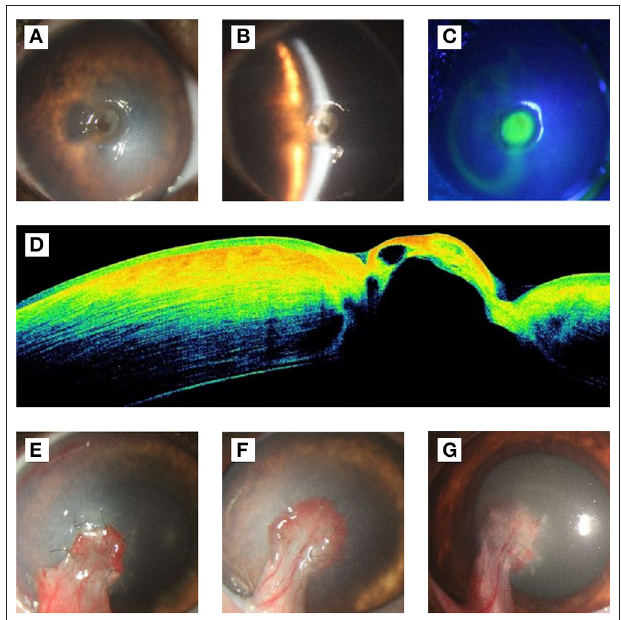
FIGURE 1 | Ophthalmological examination results before and after the operation. (A) Frontal view of cornea, there was a circular ulcer (approximately 3mm in diameter) at the center of the cornea, and the anterior chamber of the left eye was invisible. (B) Slit-lamp examination. The result showed that the corneal epithelium was disappear in ulcer, stromal around the ulcer was edema, and the depth of the ulcer was about 70% of the corneal thickness.